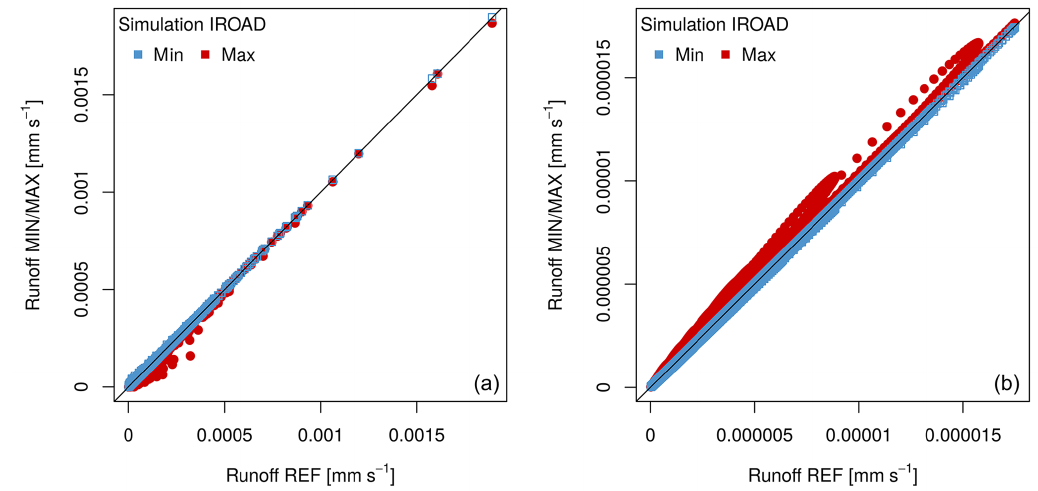
Figure 4. (a) Comparison of total urban runoff ( R town ) between the reference simulation (REF) and both the MIN simulation (blue) and MAX simulation (red) for parameter I rd on the left side, and (b) comparison of the sewer runoff due to soil water infiltration ( R sew ) between the reference simulation (REF) and the MIN (blue) and MAX (red) simulations for parameter I rd on the right side.